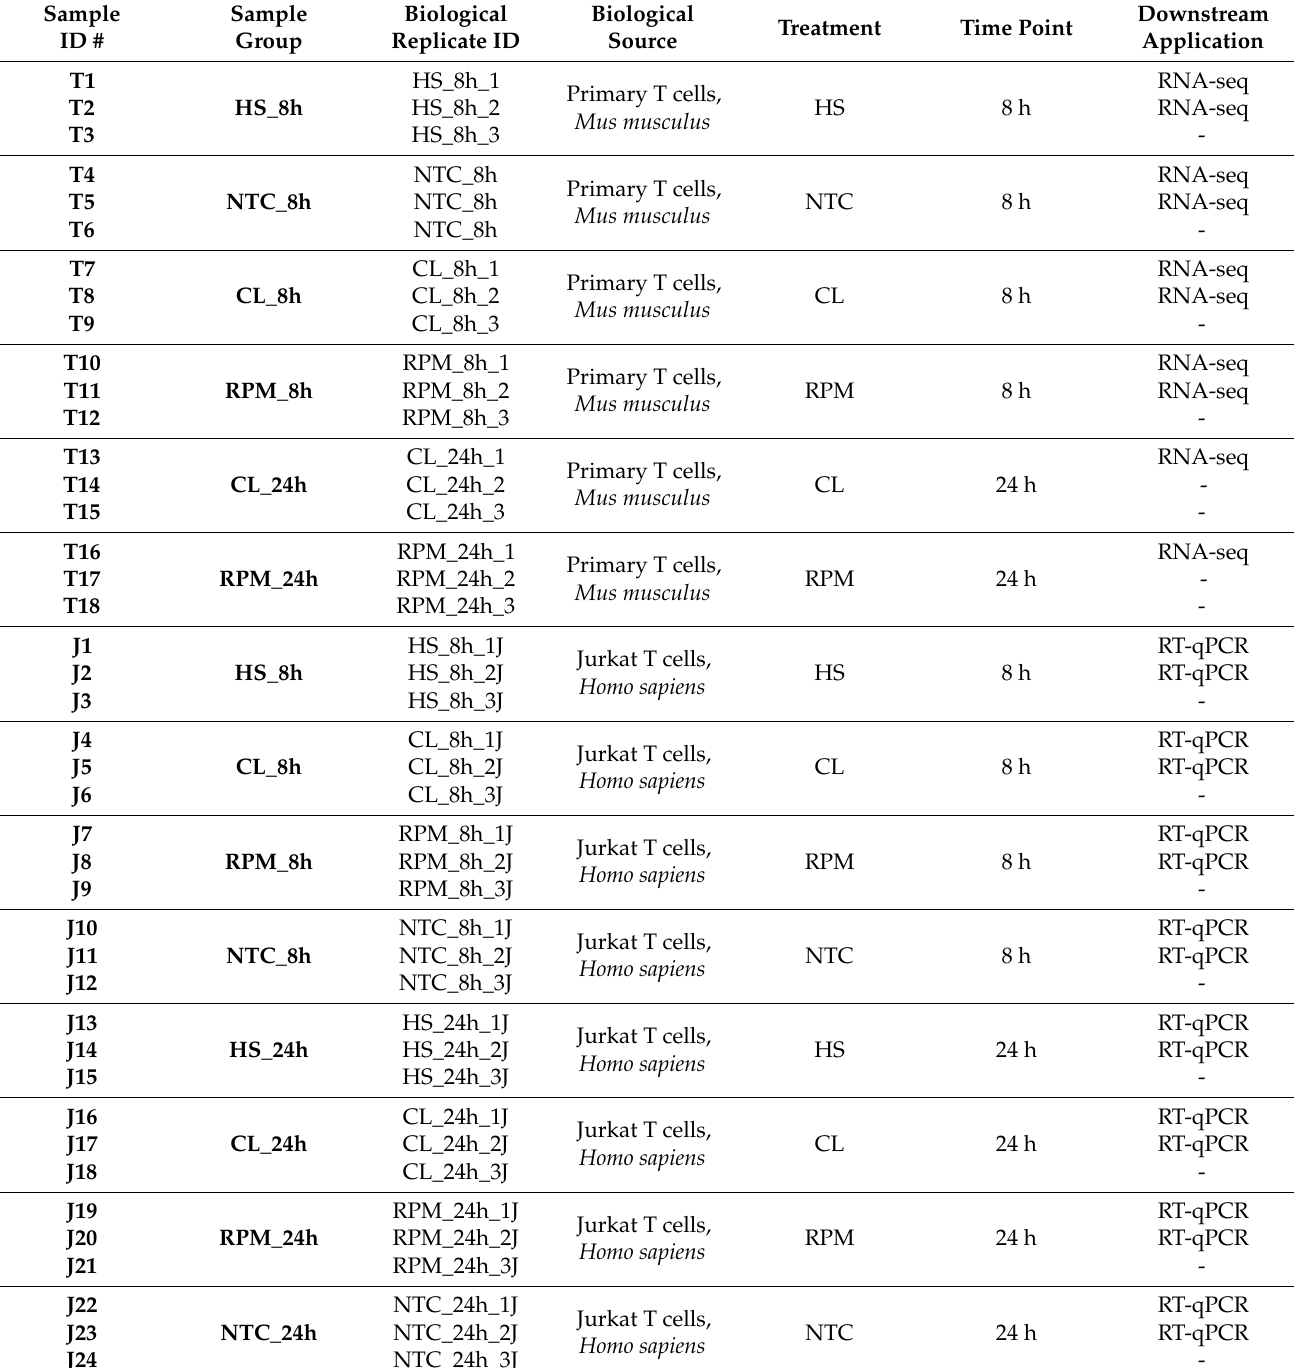
Table A7. Cell samples used in simulated microgravity (SMG) and hydrodynamic stress (HS) experiments or in non-treated controls